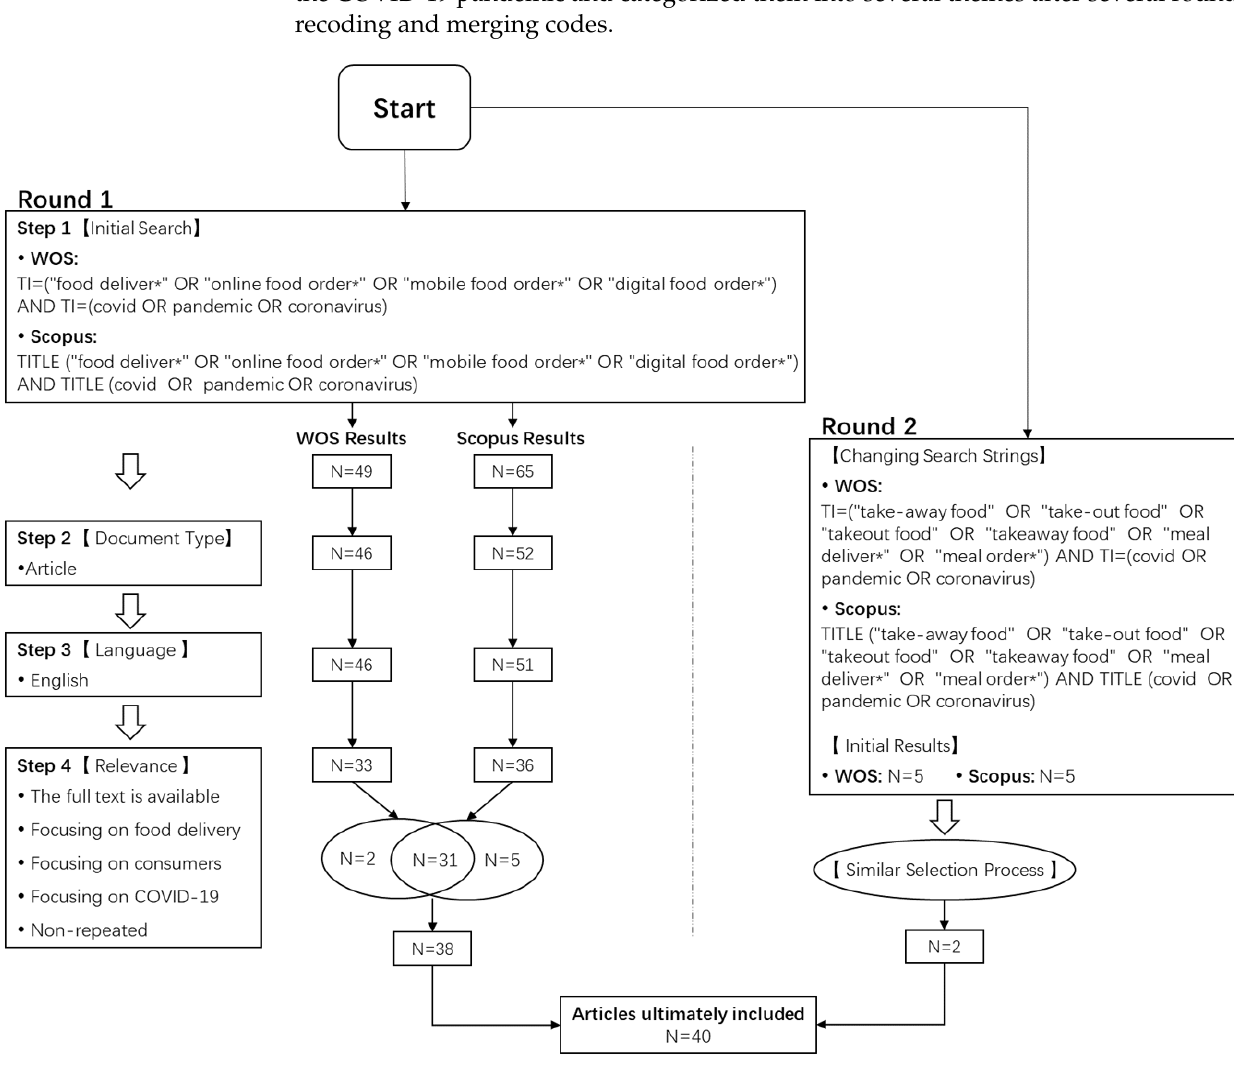
Figure 1. Literature searching